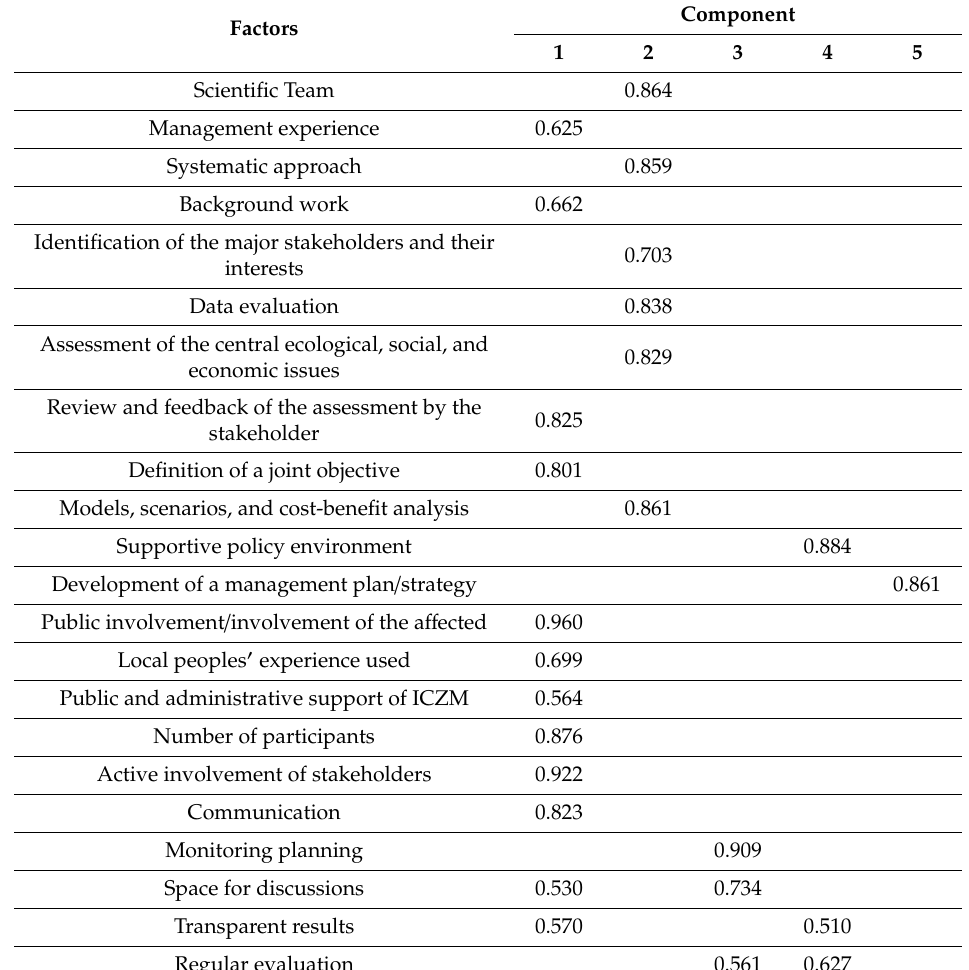
Table 6. Rotated principal component matrix of standardized ICM factor loadings (1. Stakeholder Involvement; 2. Research Base; 3. Planning Consistency; 4. Policy Environment, and 5. Development of Plans /